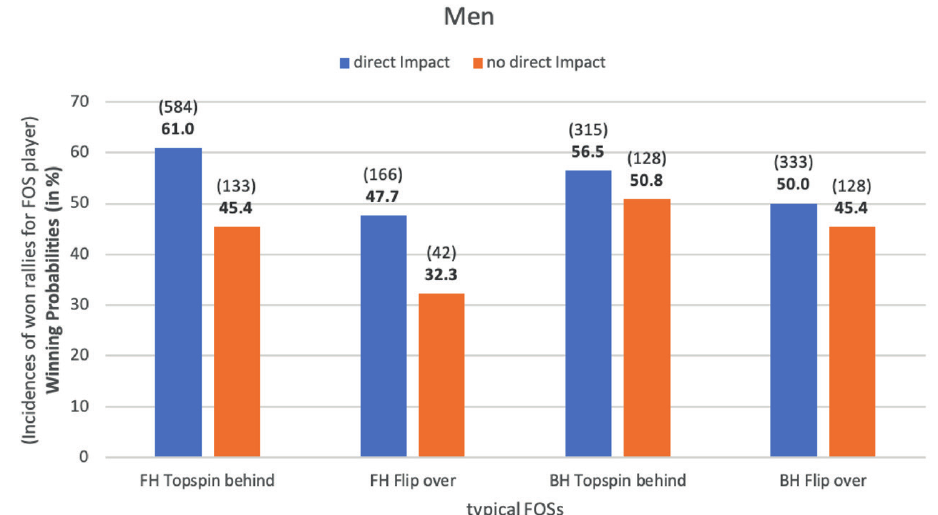
Figure 11. Incidences of won rallies and winning probabilities for the FOS player using the typical FOSs separated by direct or no direct impact of the FOS for men’s matches.